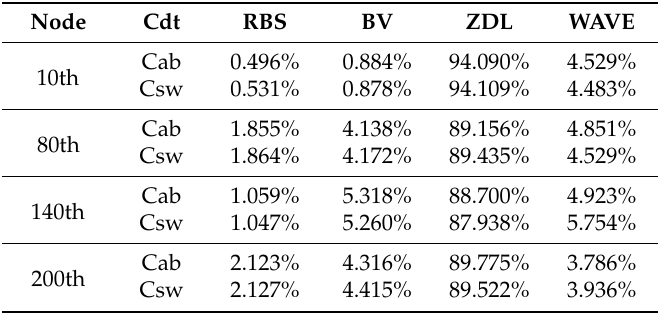
Table 13. Percentage relative to total frequency’s amplitude of different